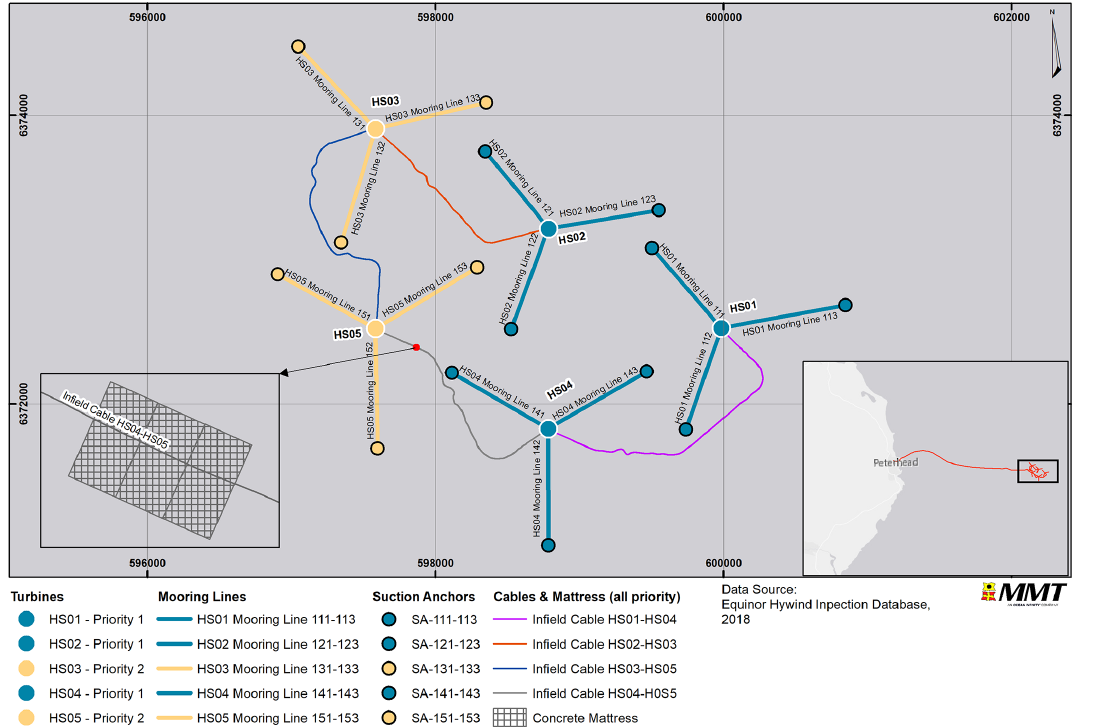
Figure 3. Overview of survey area and priority and non-priority structures. Basemap sources: © OpenStreetMap contributors 2021. Dis- tributed under the Open Data Commons Open Database License (ODbL) v1.0.